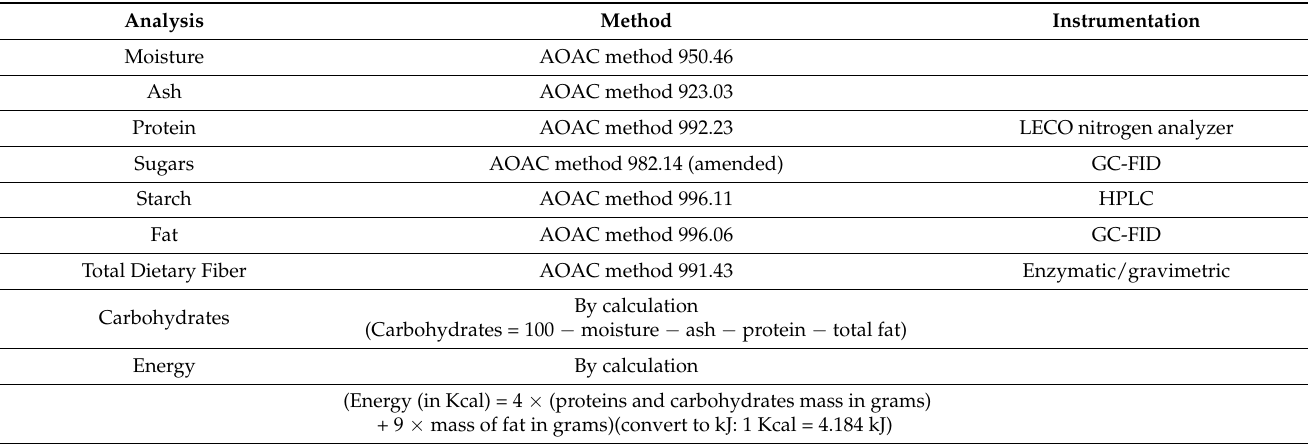
Table 7. Methods used for composite analysis